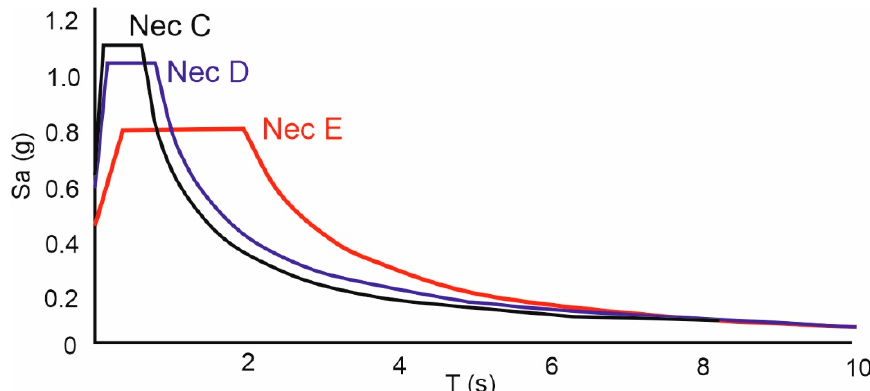
Figure 6. Elastic seismic spectra of NEC-11 [46] accelerations for soil and rock profiles.